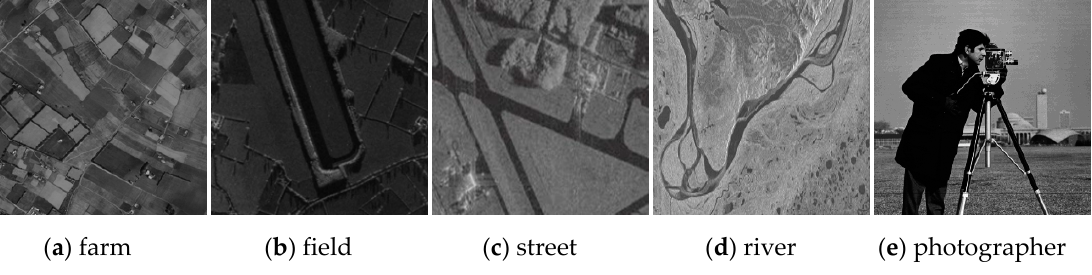
Figure 4. Selected reconstruction images.